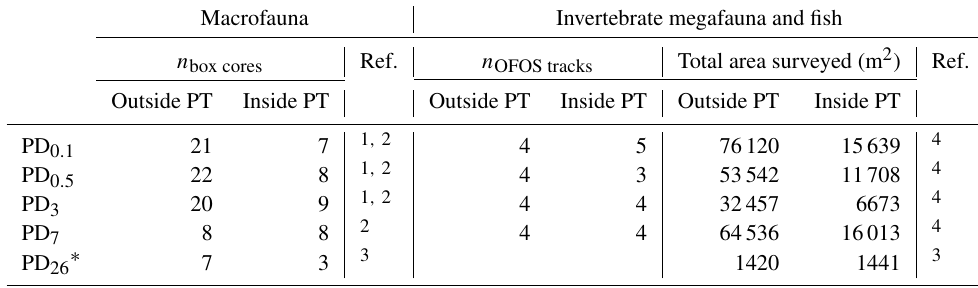
Table 1. Number of box cores ( n box cores ) taken for macrofauna sampling outside plough tracks (outside PT) and inside plough tracks (inside PT) directly after the disturbance event in March 1989 (PD 0 . 1 ), 0.5-year post-disturbance (September 1989, PD 0 . 5 ), 3-year post- disturbance (January 1992, PD 3 ), 7-year post-disturbance (February 1996, PD 7 ), and 26-year post-disturbance events (September 2015, PD 26 ). Number of “OFOS” tracks (“ocean floor observatory system”; n OFOS tracks ) analyzed to estimate invertebrate megafauna and fish density and total area of seafloor (m 2 ) that was surveyed during each sampling event outside and inside plough tracks. References: 1 Borowski and Thiel (1998), 2 Borowski (2001), 3 this study, 4 Bluhm (2001). Macrofauna Invertebrate megafauna and fish n box cores Ref. n OFOS tracks Total area surveyed (m 2 ) Ref. Outside PT Inside PT Outside PT Inside PT Outside PT Inside PT PD 0 . 1 21 7 1 , 2 4 5 76120 15639 4 PD 0 . 5 22 8 1 , 2 4 3 53542 11708 4 PD 3 20 9 1 , 2 4 4 32457 6673 4 PD 7 8 8 2 4 4 64536 16013 4 PD 26 ∗ 7 3 3 1420 1441 3